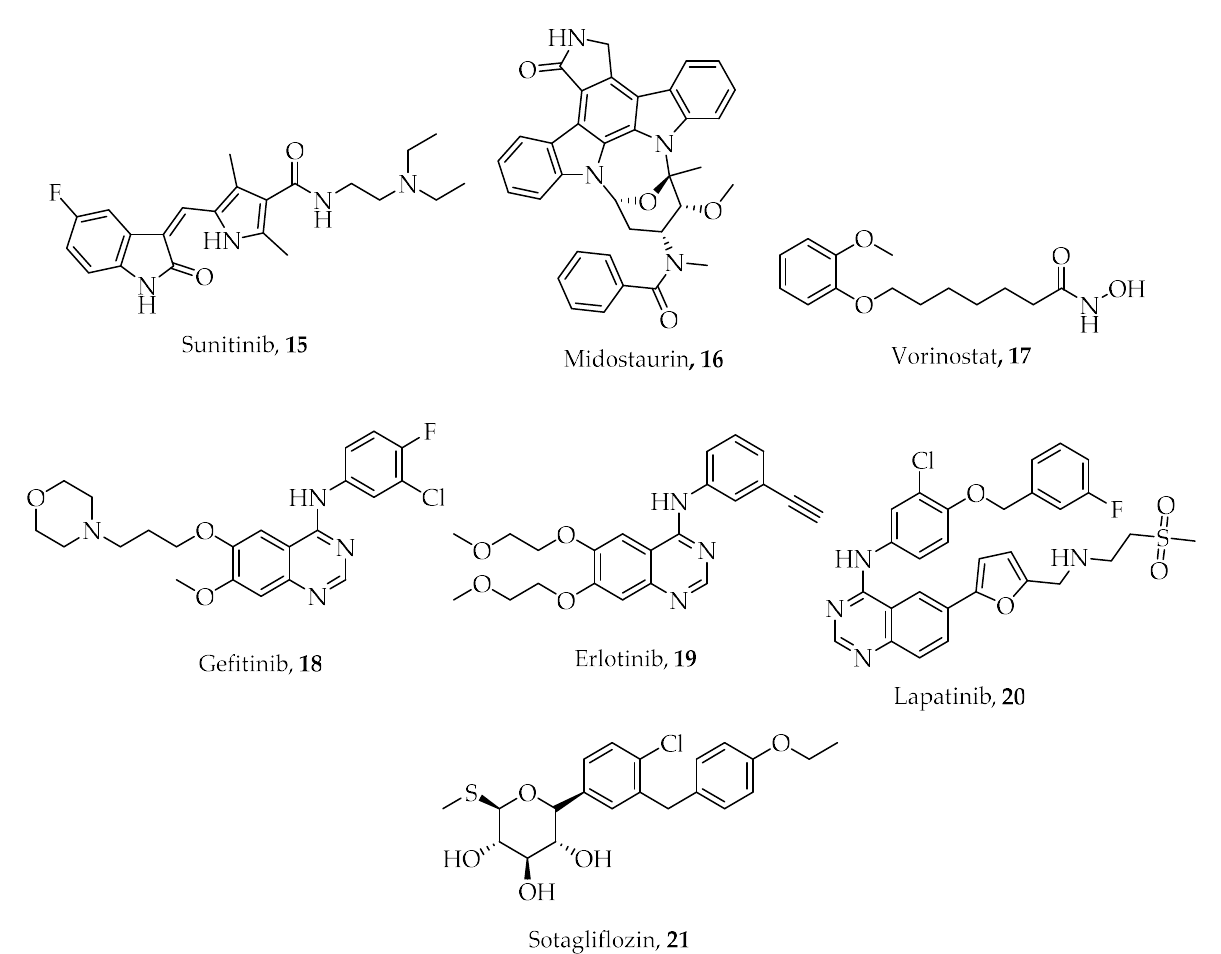
Figure 2. Chemical structures of some heterocyclic multi-target anticancer agents. Compounds 15–17 are in clinical use while 18–21 are in various stages of clinical trials.